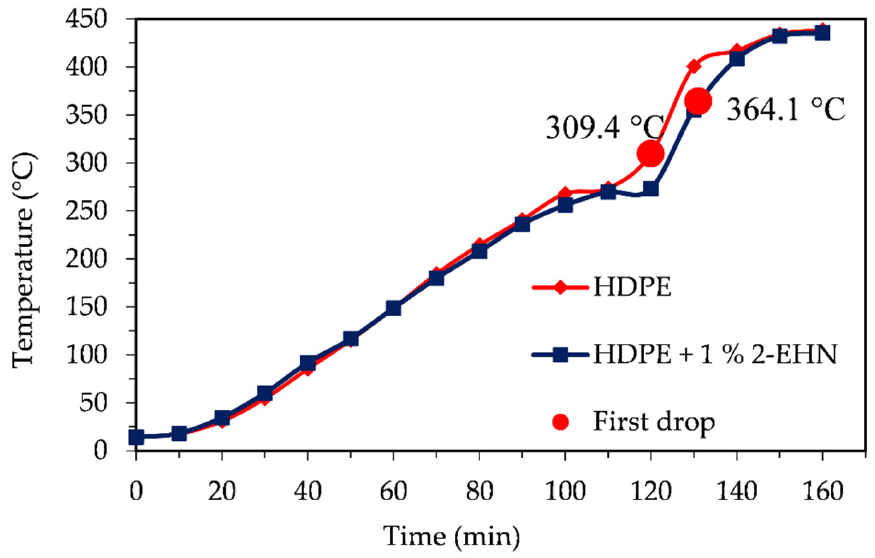
Figure 2. Temperature profile of the pyrolysis process for HDPE (black), HDPE + 1% 2-EHN (red), first drop (red dot).